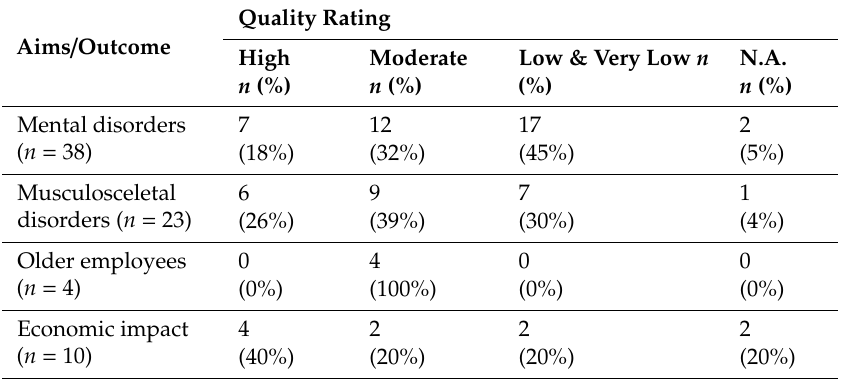
Table 1. Distribution of reviews by quality rating and aims /